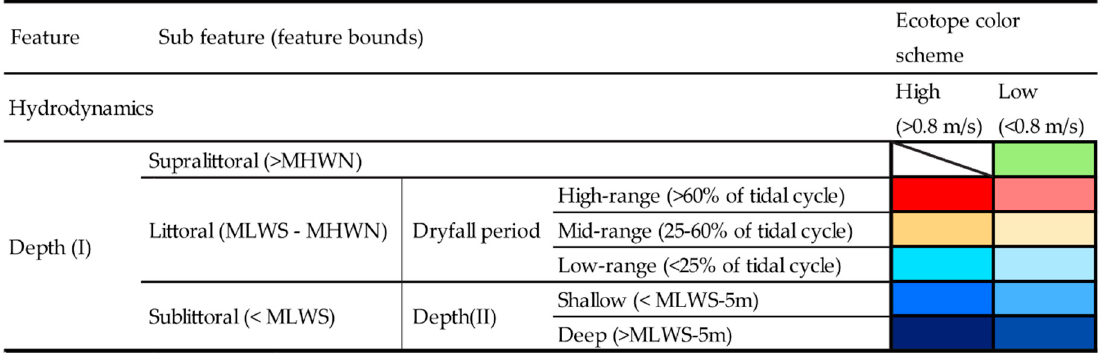
Figure 2. Ecotope feature classes and feature bounds.